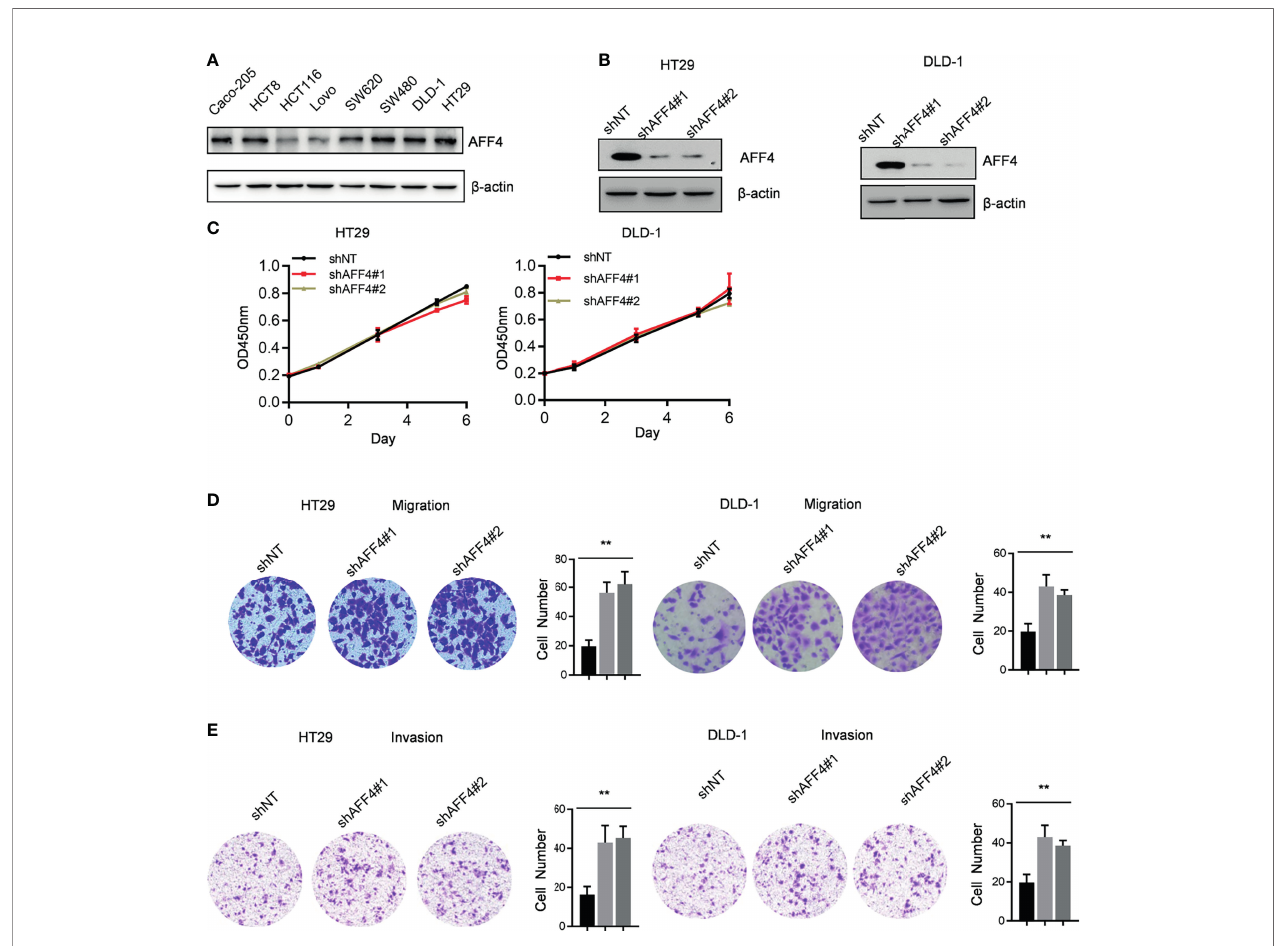
FIGURE 2 | AFF4 depletion promotes CRC cell migration and invasion but not proliferation. Data are from three independent experiments. Data are presented as the mean ± SD or SEM and are analyzed by unpaired t -tests or two-way ANOVA. ** p < 0.01. (A) Western blot assay was performed to determine AFF4 protein level in eight colorectal cancer cell lines. b -Actin was performed as an internal control. (B) Western blot assay was performed to determine AFF4 knockdown ef fi ciency in HT29 and DLD-1. b -Actin was performed as an internal control. Sh, small hairpin; NT, nontarget. (C) CCK-8 assay was performed to measure the effect of AFF4 knockdown on HT29 and DLD-1 cell proliferation. A total of 20,000 cells were seeded in 48-well plates at the start point and collected at the indicated time points. The calculation value of cell number was readout by OD450 nm using Microplate System. (D, E) Cell migration or invasion was performed by seeding 50,000 HT29 and DLD-1 cells expressing shNT, shAFF4#1, or shAFF4#2 in the serum-free medium, and migrated (D) or invasive (E) cells through the 8- m m hole were fi xed by 80% cold methanol and stained by crystal violet. Of note, the invasion assay was performed by adding Matrigel in the 8- m m hole. The calculation of cell number was executed by differential interference contrast microscope